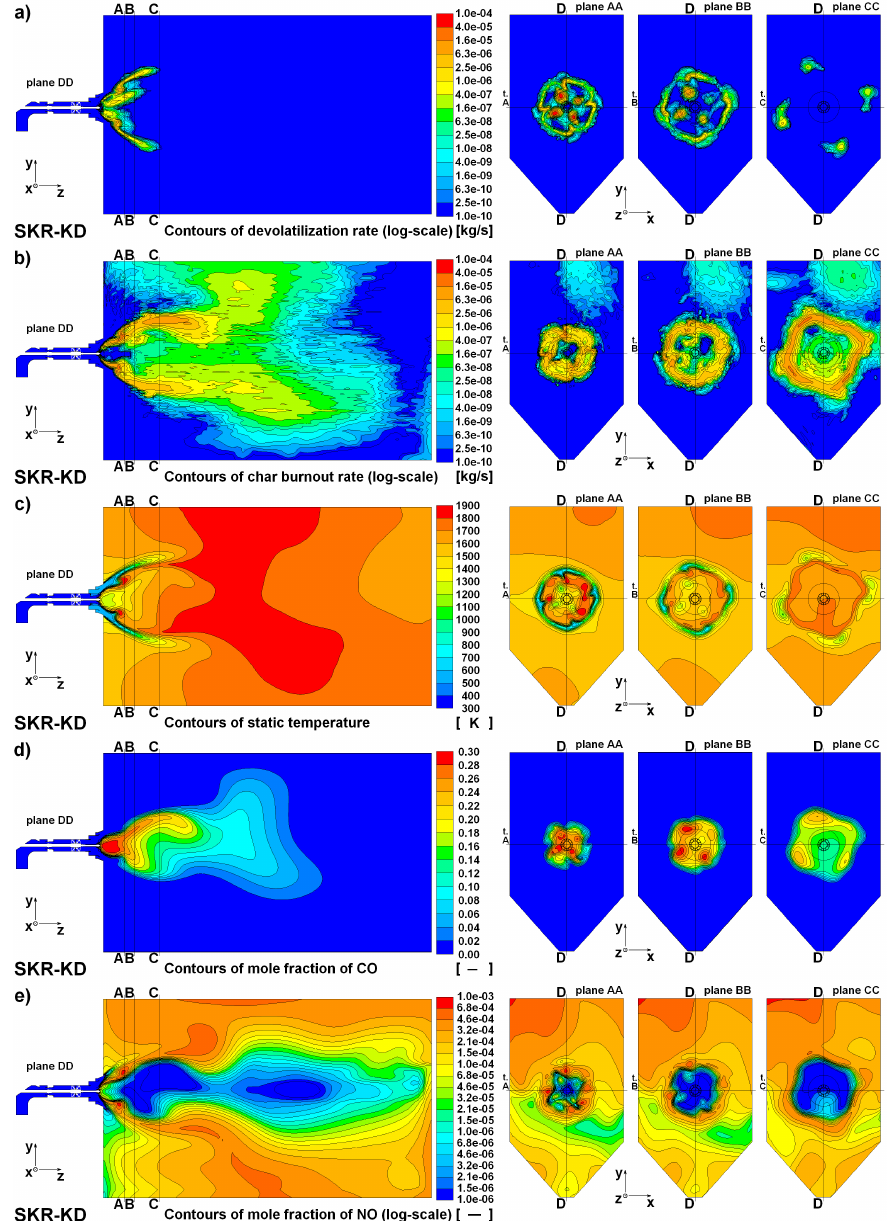
Figure 10. Results obtained by means of the SKR-KD model. ( a ) Devolatilization rate; ( b ) char burnout rate; ( c ) static temperature; ( d ) mole fraction of CO; and ( e ) mole fraction of